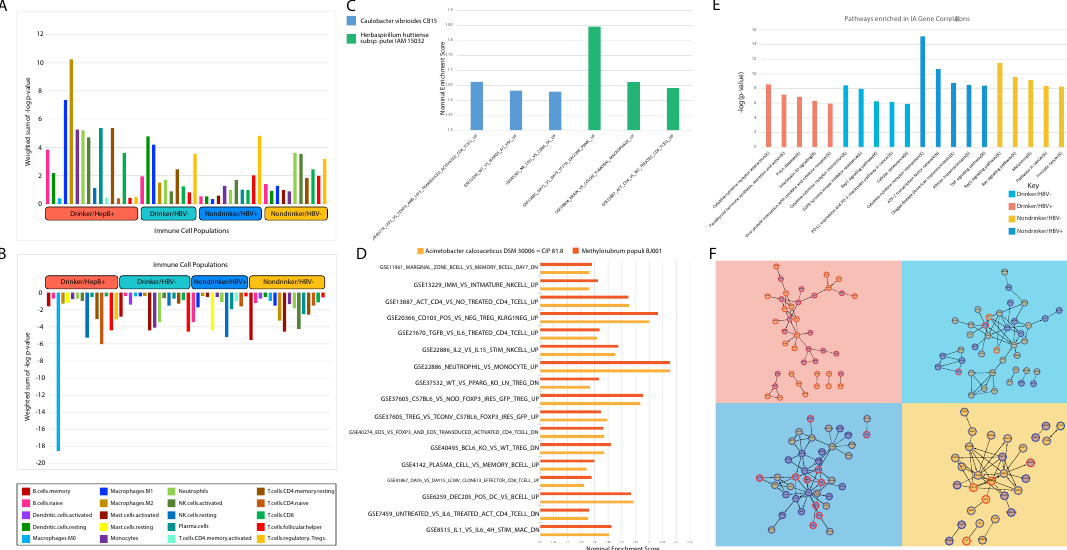
Figure 6. Correlation of microbial abundance to immune dysregulation. Immune cell population dysregulation in the ( A ) positive and ( B ) negative direction was analyzed for each cohort. Enrichment of immune signatures was further analyzed using gene set enrichment analysis (GSEA) on ( C ). HBV +/ drinker and ( D ) HBV +/ nondrinker data. ( E ) Top immune pathways dysregulated were identified by correlating immune associated genes to microbial abundance. ( F ) IA gene interaction diagram of genes correlated with microbe abundance in each cohort. Red or blue outlines of the circle indicate whether the abundance of the microbe associated with the IA gene is upregulated or downregulated in its respective cancer cohort vs. normal comparison, respectively. Orange or purple fill demonstrate that microbial abundance is positively or negatively correlated with IA gene expression,